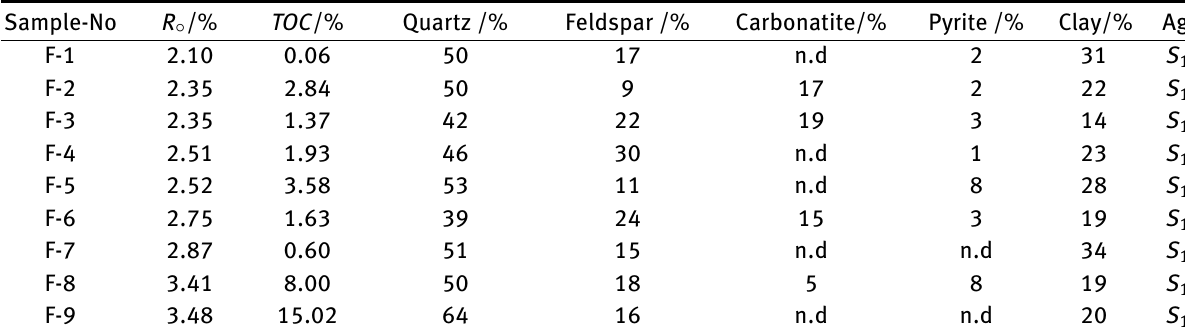
Table 1: List of mineral composition of organic-rich shale samples. Sample-No